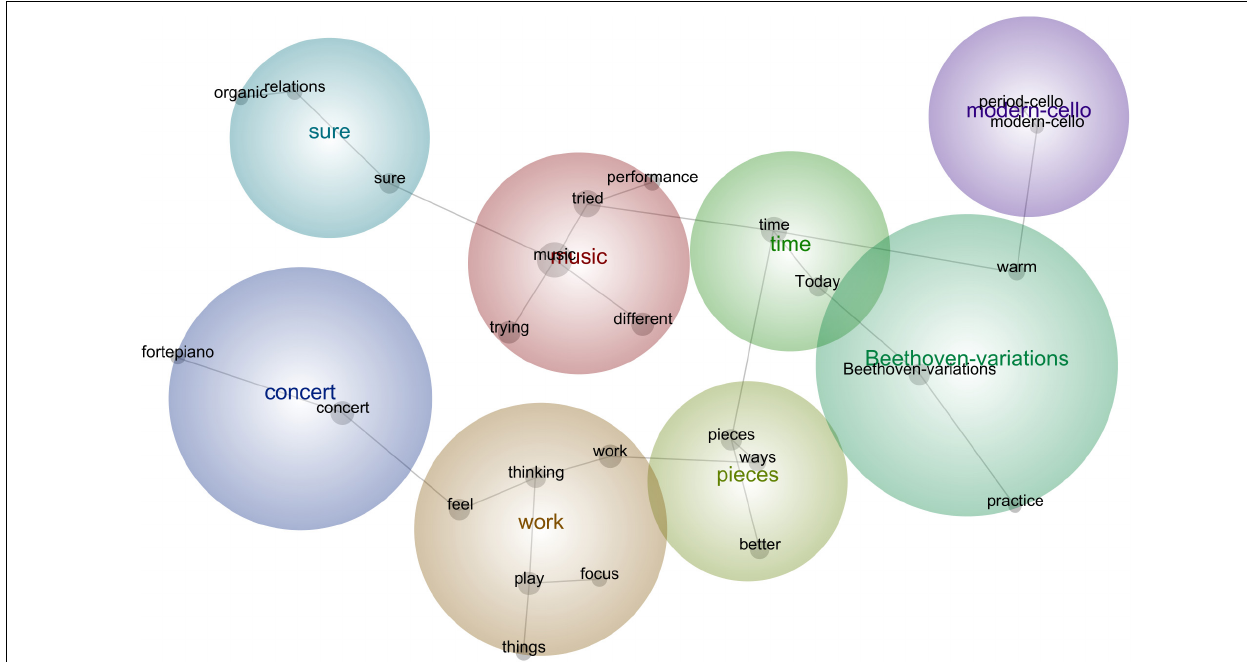
FIGURE 6 | Leximancer concept map for Concert 2.